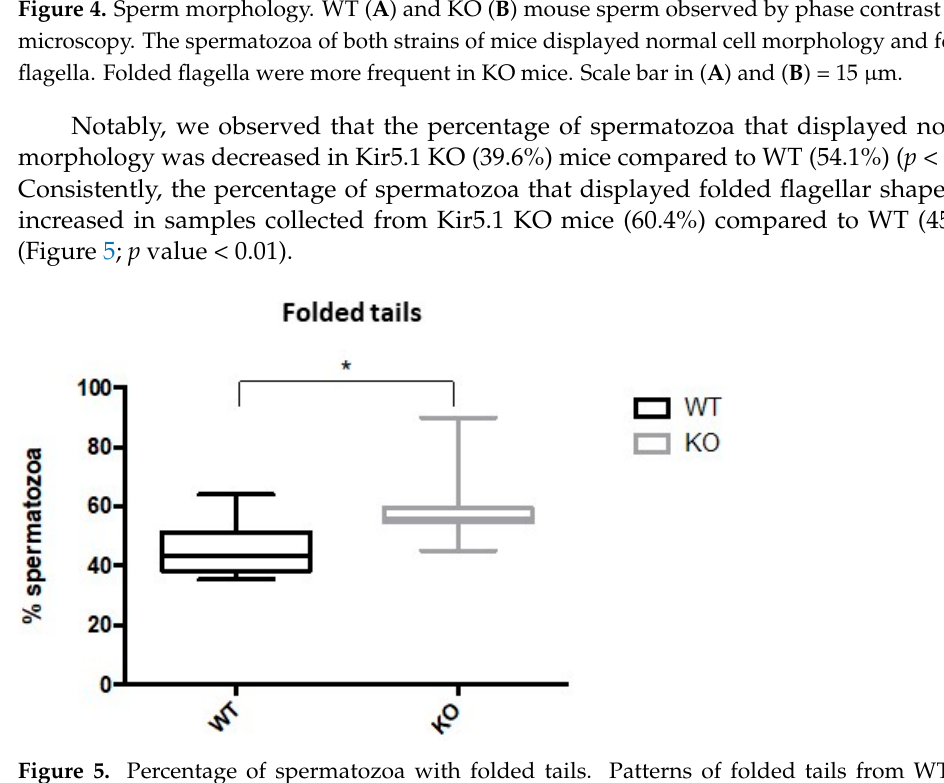
Figure 5. Percentage of spermatozoa with folded tails. Patterns of folded tails from WT and KO mice were analyzed and quantified by phase-contrast microscopy. The box plot showed a significantly higher percentage of spermatozoa with folded tails in the mutant animals compared to WT (* p < 0.01).